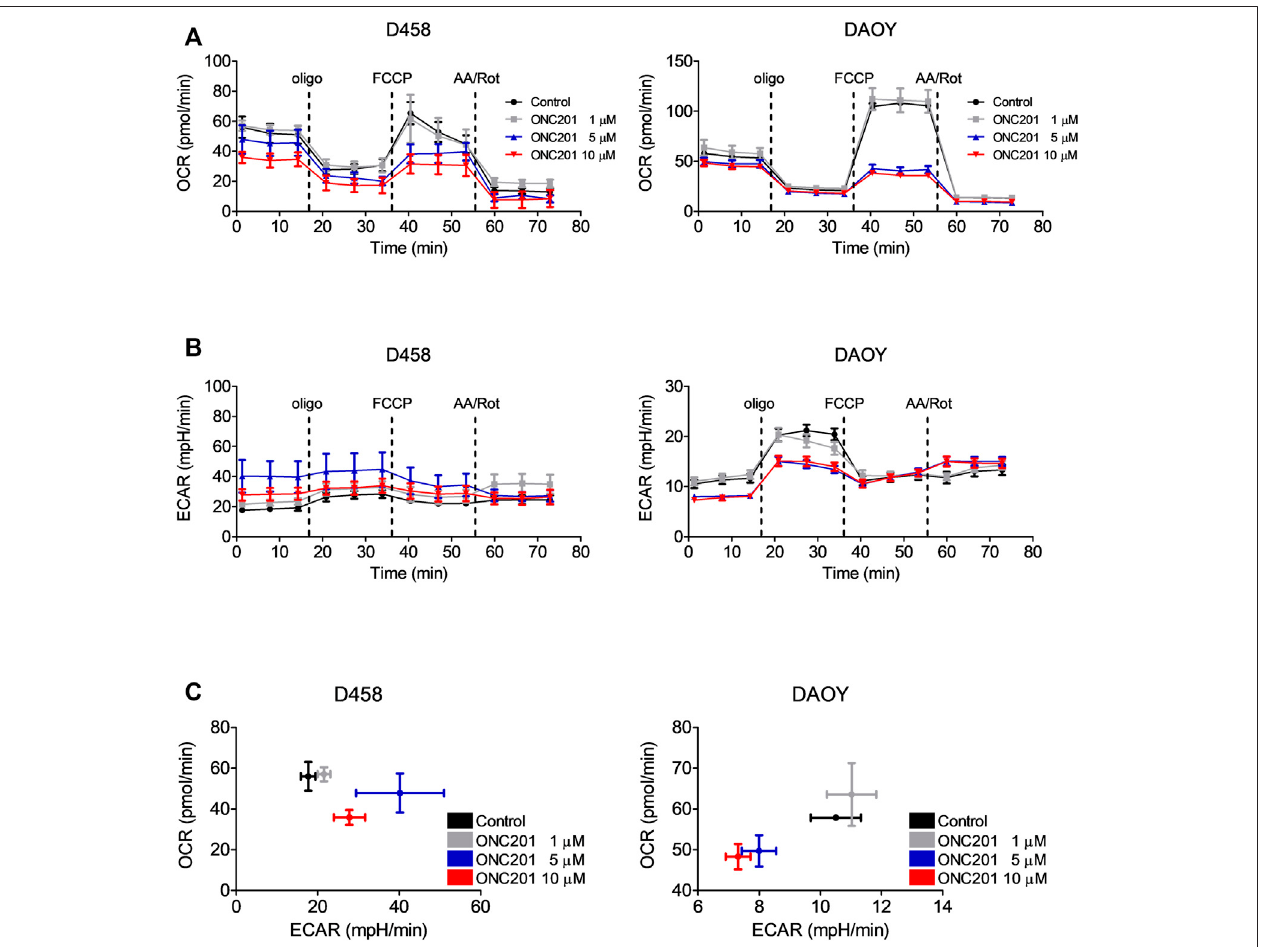
FIGURE 2 | ONC201/TIC10 suppresses OXPHOS and differentially modulates the glycolytic rates in D458 an DAOY cells. (A) , D458 and DAOY cells were treated for 24 h with indicated concentrations of ONC201/TIC10. Mitochondrial stress tests were performed. Oxygen consumption rates (OCR) were continuously recorded whileoligomycin(olig),FCCPandantimycinA/rotenone(AA/Rot)weresequentiallyinjectedintothewells.MeanandSDoffourtechnicalreplicates representativefortwo independentexperiments. (B) ,Extracellularacidi fi cationrates(ECAR)forcellstreatedasdescribedforA.MeanandSDoffourtechnicalreplicatesrepresentativefor two independent experiments. (C) , D458 and DAOY cells were treated for 24 h with indicated concentrations of ONC201/TIC10. Graphical representation of baseline OCR/ECAR-values. Mean and SD of four technical replicates representative for two independent experiments.